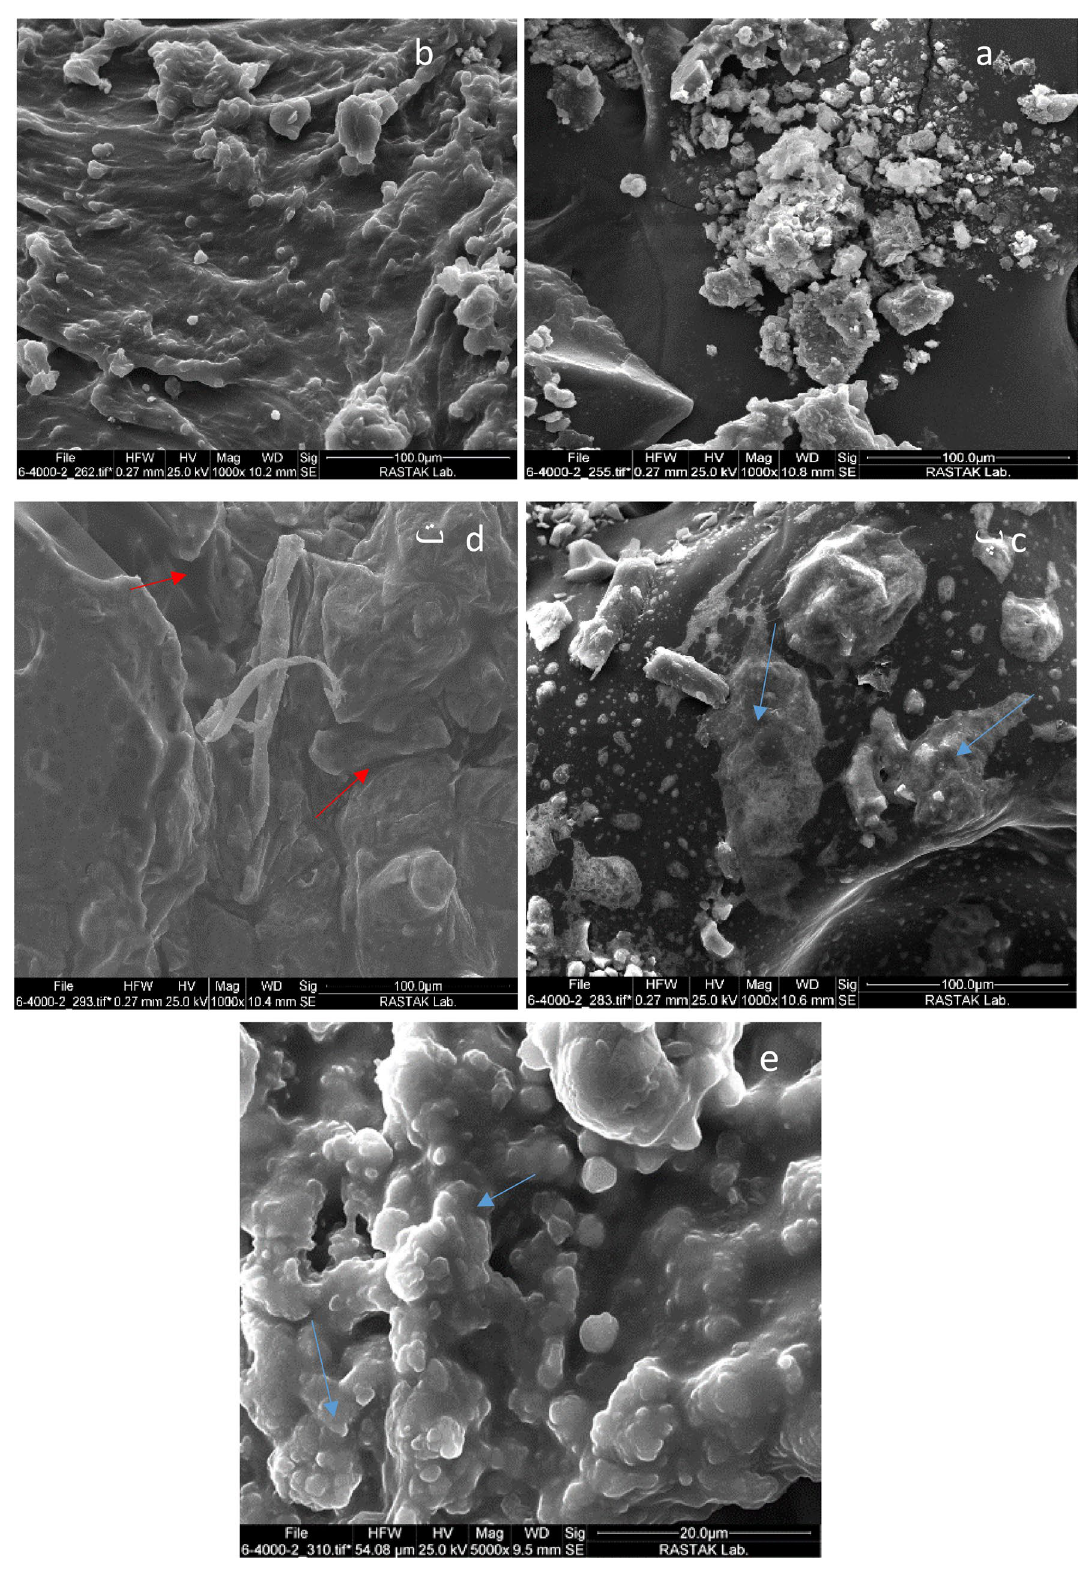
Fig. 1 The micrographs resulting from the SEM tests for samples a control PP, b control PE, c PP exposed to the microbial strain B, d PE exposed to the microbial strain C, and e PP exposed to microbial strain E for three